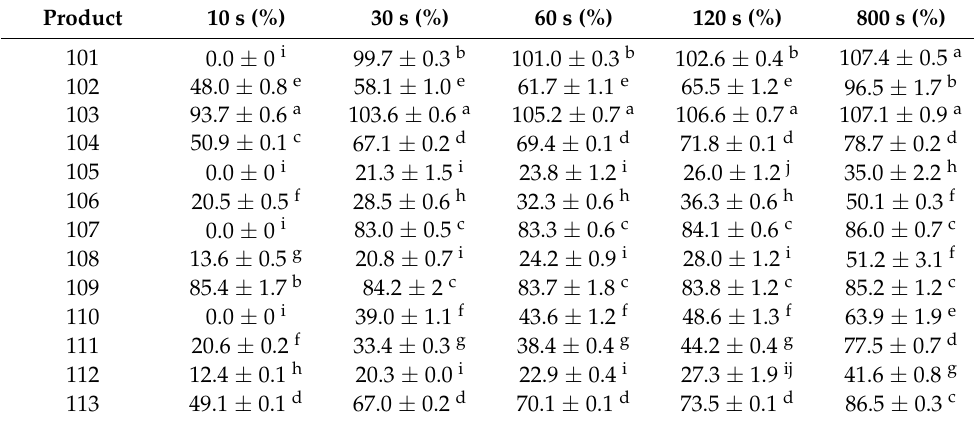
Table 8. Values of the percentage of the emulsion’s restructuring at different times for the 13 cosmetic products.